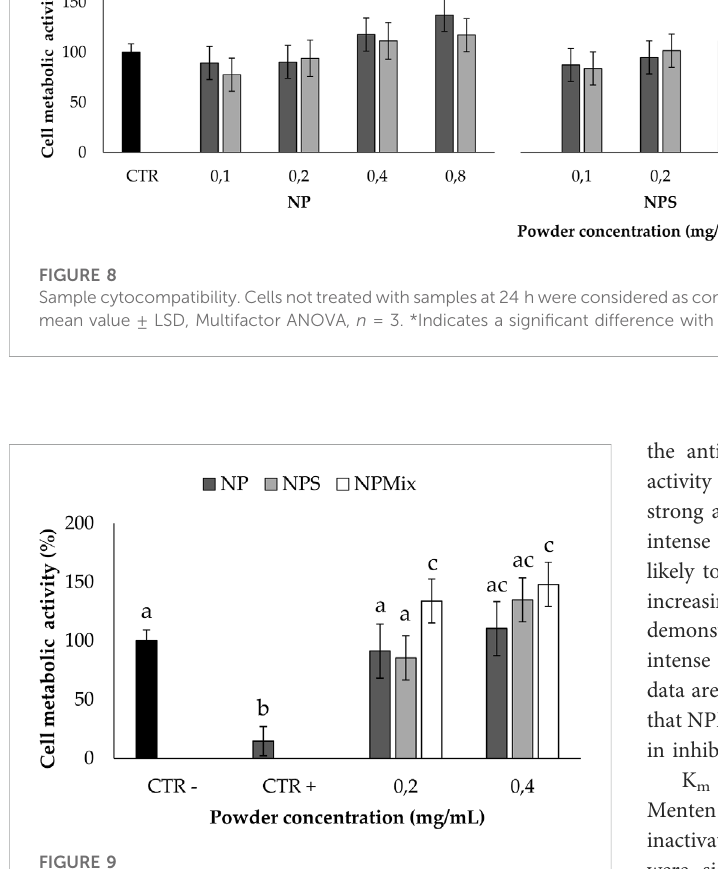
FIGURE 9 Oxidative stress protection test. Cells not treated with samples and H 2 O 2 at 24 h were considered a negative control (100% of the metabolic activity%), while cells not treated with samples but with H 2 O 2 were considered a positive control. Data are reported as mean value ± LSD, Multifactor ANOVA, n = 3. Letters (a, b, c, and ac) are used to compare the means of different groups. If the letters are different, there is a statistically signi fi cant difference between the means ( p < 0.001); if the letters are the same, there is no statistically signi fi cant difference between the means ( p >